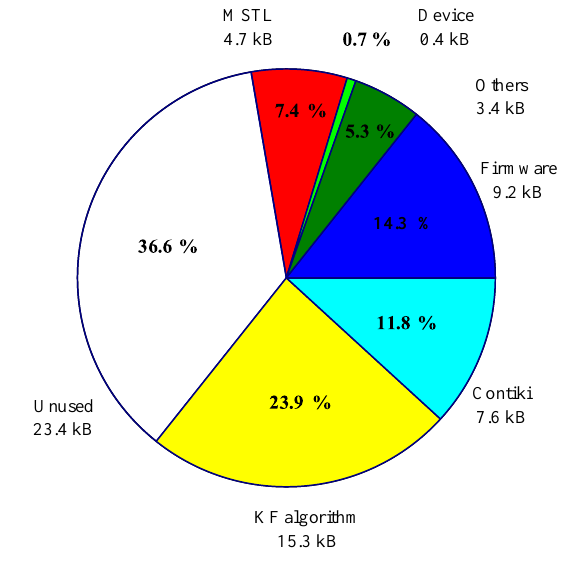
Figure 15. The usage of RAM on the NCAP (total memory: 64kB).